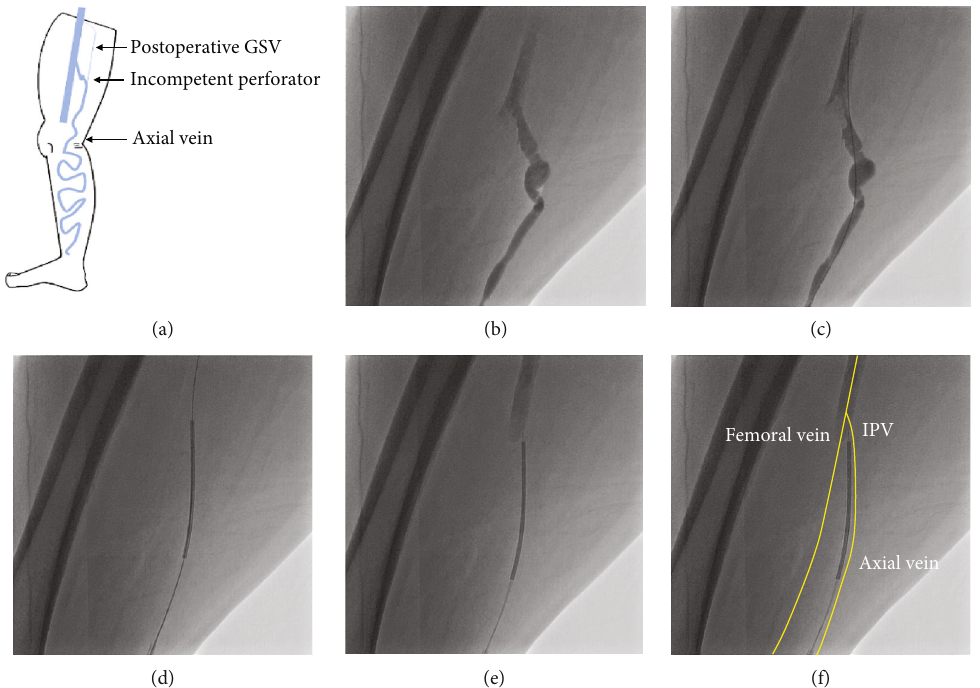
Figure 2: Schema of our patient ’ s (a) recurrent varicose vein and (b – f) fl uoroscopic images of venography and selective ablation technique. Venography showed a dilated incompetent perforator vein (IPV) (b). A 0.025-inch wire was crossed to the femoral vein (FV) (c). A radiofrequency ablation (RFA) catheter was advanced over the wire to the FV (d). The RFA catheter was pulled back and adjusted at the border between the FV and the perforator vein, while contrasting from the catheter lumen (e, f). GSV: great saphenous